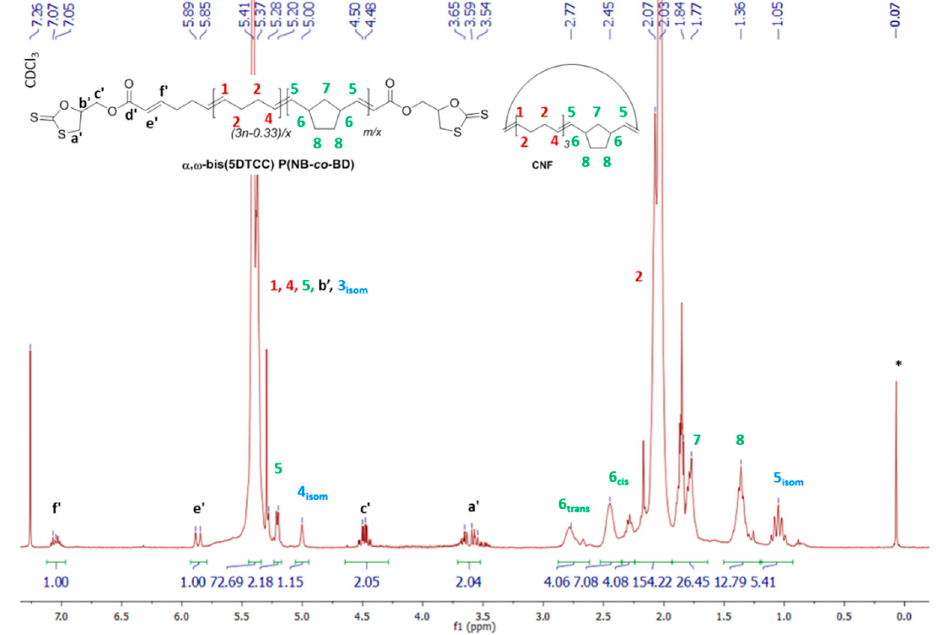
Figure 5. 1 H NMR spectrum (500 MHz, CDCl 3 , 25 °C) of an α , ω -bis(dithiocarbonate) P(NB- co -CDT) (Table 4, entry 1) copolymer sample that was prepared upon dithiocarbonatation of an α , ω -bis(dioxetane) P(NB- co -CDT) copolymer with CS 2 /LiBr (Table 3, entry 5).